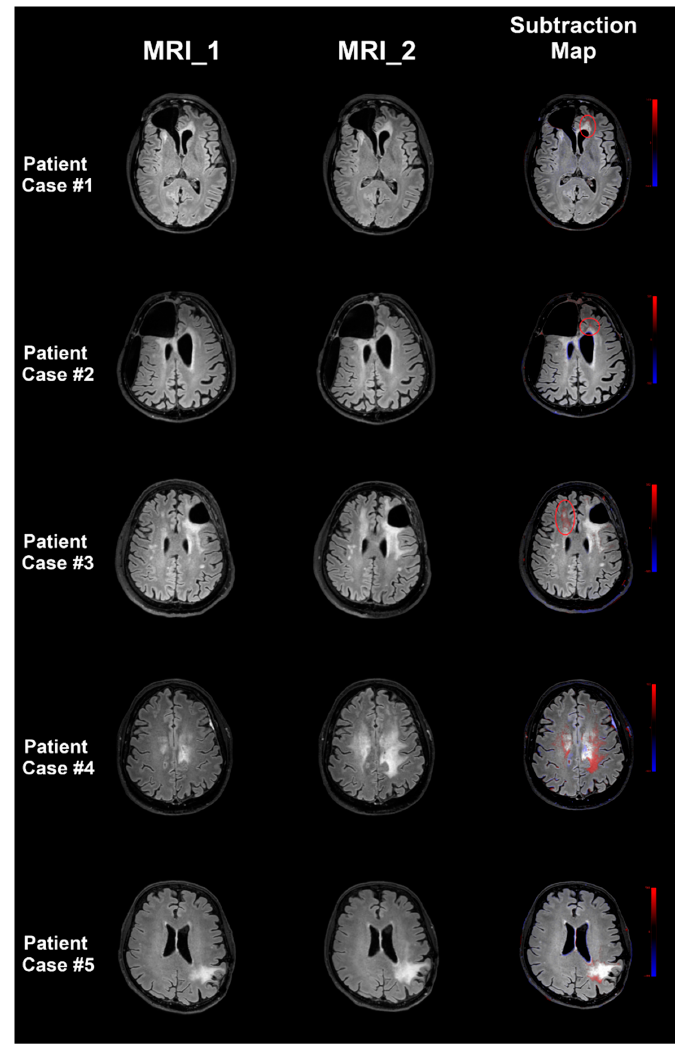
Figure 2. Exemplary patient cases. Five exemplary patient cases with increasing fluid attenuated inversion recovery (FLAIR) signal, thus suspected (pseudo)progression, are shown in this figure. Axial slices of the FLAIR sequences of MRI_1 and MRI_2 as well as the subtraction maps (SMs) are shown, which use color-coding to show signal changes over time (new or progressive lesions are shown in red). For patient cases #1, #2, and #3, progressive FLAIR signal is rather subtle and is enclosed by red circles (located adjacent to the left-hemispheric anterior horn of the lateral ventricle for patient case #1, in the left-hemispheric frontal white matter close to an enlarged left-sided lateral ventricle in patient case #2, and in the right-hemispheric frontal white matter close to the lateral ventricle in patient case #3). In patient cases #4 and #5, progressive FLAIR signal was more extensive, and thus also easier to detect without SMs when comparing MRI_1 and MRI_2 (located in the bihemispheric centrum semiovale for patient case #4 and in the left-hemispheric parietal white matter extending to the lateral ventricle in patient case #5). For patient cases #1, #2, and #3, the FLAIR signal was determined as stable / unchanged by one reader each during conventional (CONV) reading that only used MRI_1 and MRI_2, whereas it was categorized as progressive by both readers according to the SM reading. The FLAIR signal for patient cases #4 and #5 was rated as progressive by both readers during CONV and SM reading,